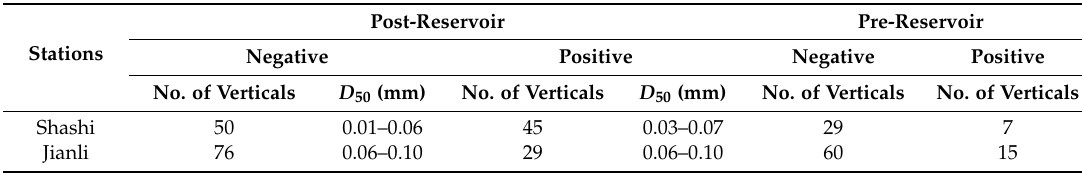
Table 3. Characteristics of vertical profiles with positive and negative gradations at Shashi and Jianli hydrological stations.